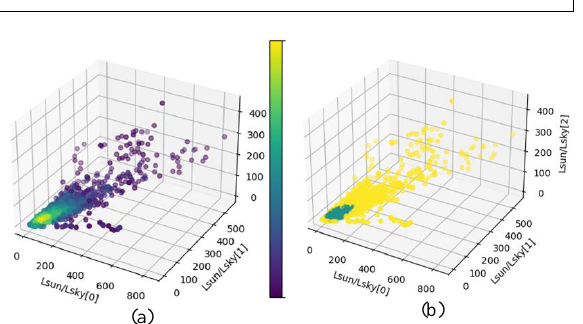
Figure 8. (a) Probability distribution estimated by GMM(n=2). (b) Pairs of the major component are inliers (green), and of the minor component are outliers